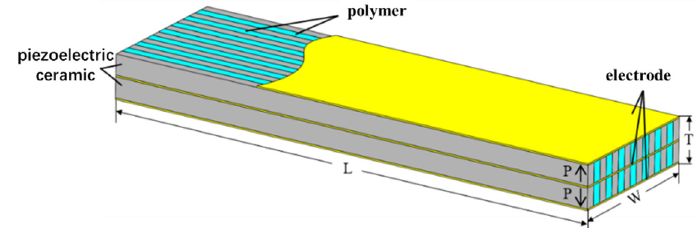
Figure 4. Double-laminated 2-2 piezoelectric